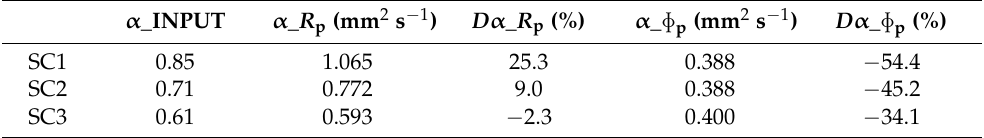
) with deviations from the input value. p